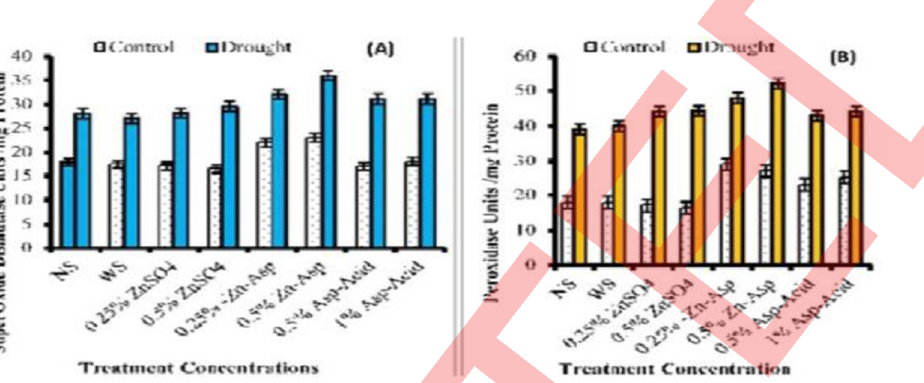
Fig 2. Effect of foliar sprinkled treatments of ZnSO 4 , Zn-Asp and L-Asp on status of Antioxidant Enzymes (A) Superoxide Dismutase SOD (B) Peroxidase POD activities in maize plants subjected to water stress in comparison with well-watered conditions (mean ± SE; n = 3.